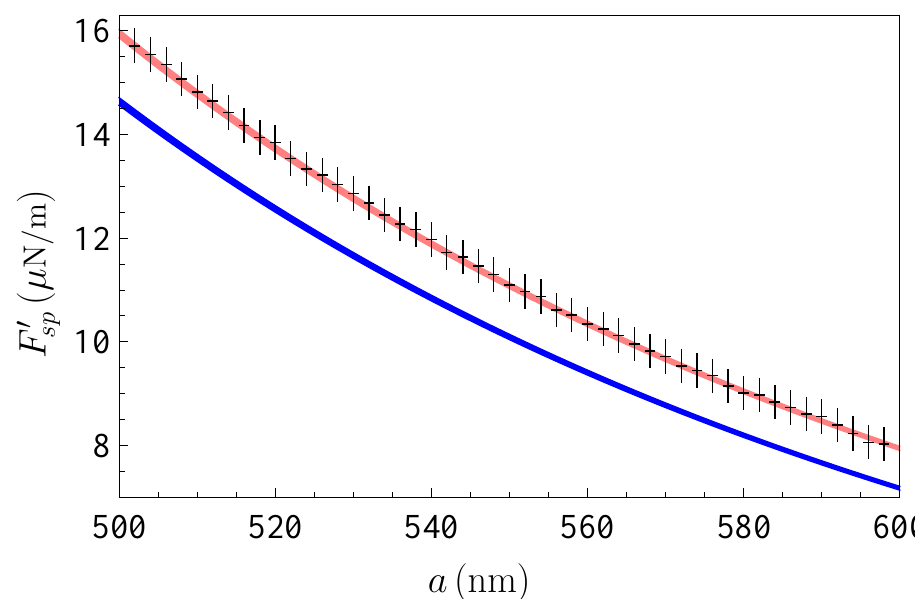
Figure 2. The gradients of the Casimir force between an Au-coated sphere and an Au-coated plate measured using a micromechanical torsional oscillator [22] (crosses) are compared with theoretical predictions of Lifshitz theory using the Drude and plasma extrapolations of the optical data of Au (blue and red bands,